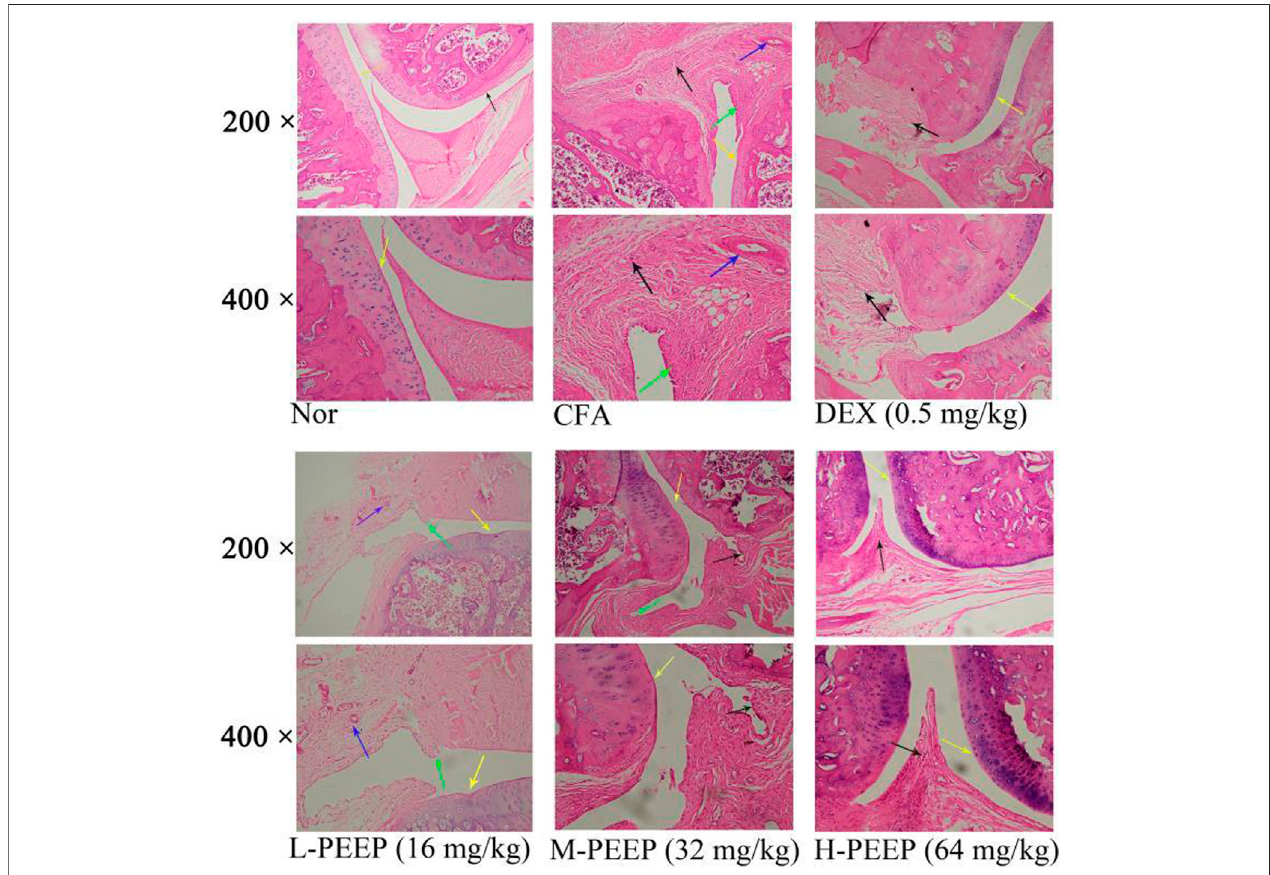
FIGURE 8 | The pathologial slice pictures of the ankle joint of CFA rats treated with various doses of. PEEP. Red arrow, articular cartilage; black arrow, synovial hyperplasia; green arrow, in fl ammatory cell in fi ltration; blue arrow, pannus.